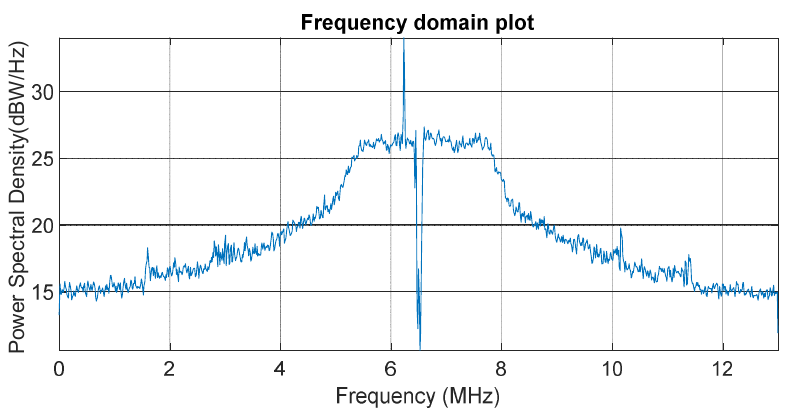
Figure 21. Frequency spectrum of the FFT excision MATLAB software simulation .